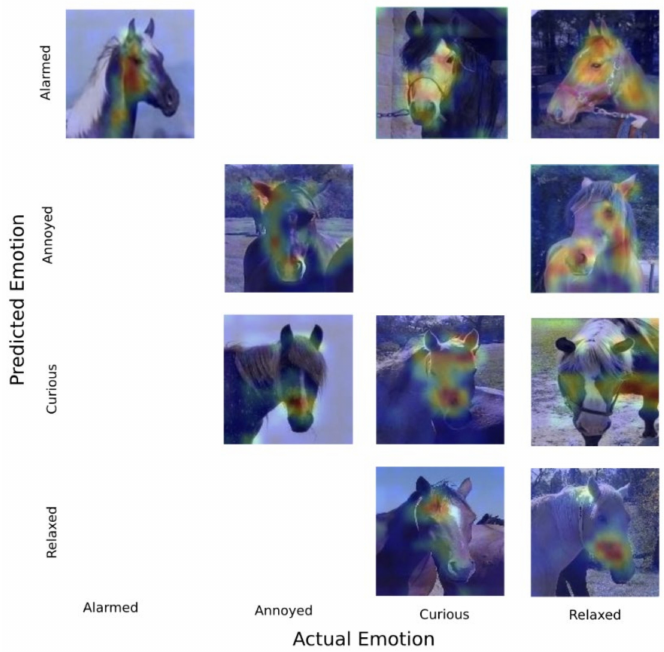
Figure 10. GradCAM overlays of the chosen test images.